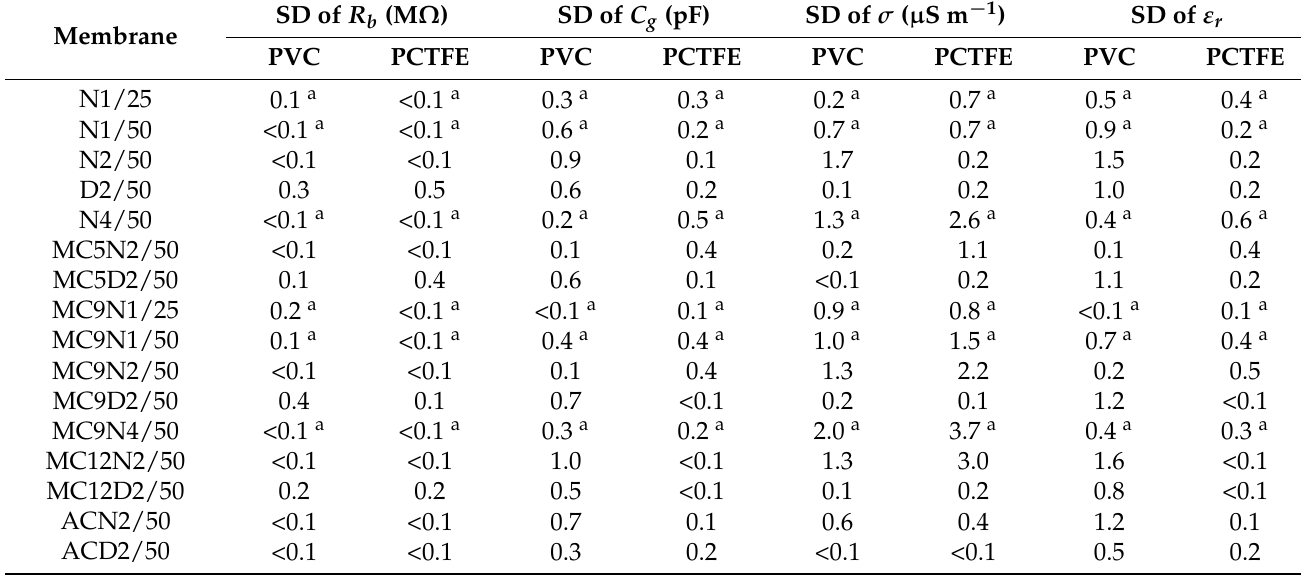
Table A3. Standard deviations for the average membrane bulk resistance ( R b ), geometric capacitance ( C g ), conductivity ( σ ), and dielectric constant ( ε r ) of the sensors in Table A2. The number of measurements and the number of sensors were n = 1 and k = 2, respectively, unless noted otherwise. See Table 1 for membrane